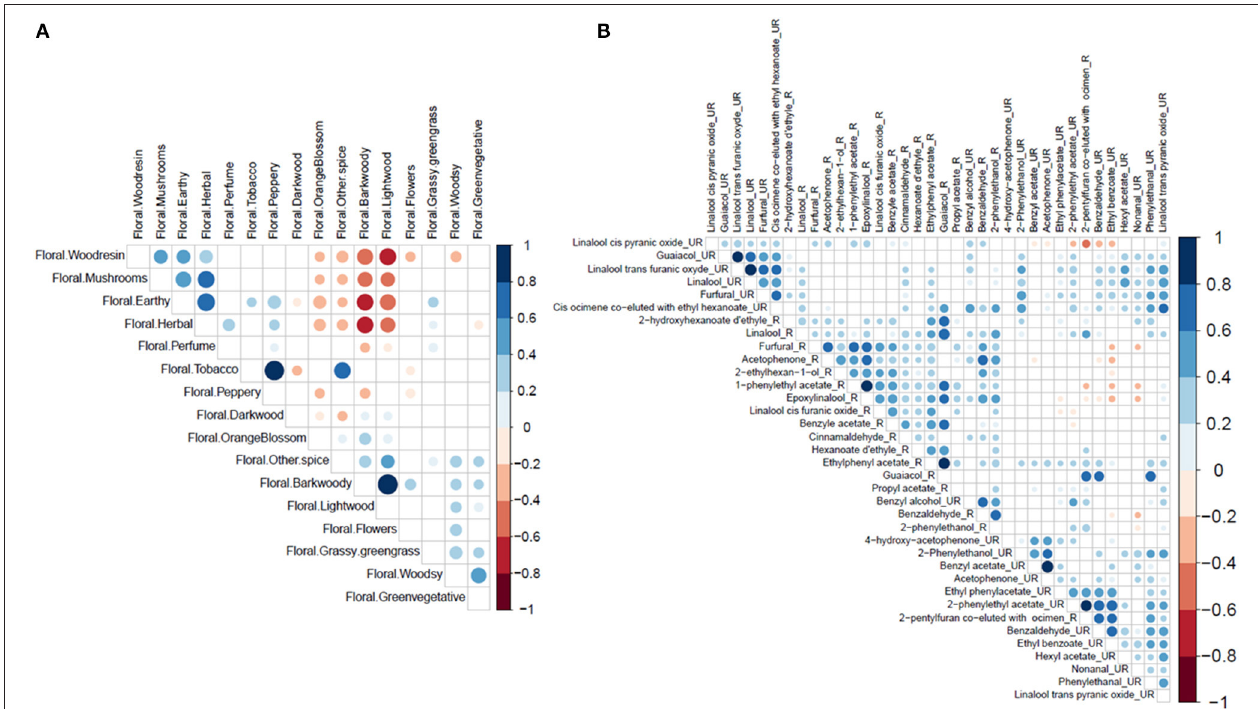
FIGURE 2 | Significant correlation matrix. (A) Correlation matrix between the sensorial profiles determined in cocoa liquor. (B) Correlation matrix between the biochemical compounds measured in unroasted (UR) and roasted beans (R). The correlations were calculated by the Pearson method. The white boxes represent no significant correlations. The colour of the circles corresponds to Pearson’s correlation coefficient. The areas of circles correspond to a p -value of correlation coefficients. The p -value threshold for a significant correlation is 0.05. The different shades of blue represent a positive correlation coefficient while the different shades of red represent a negative correlation coefficient. The intensity of the colour depends on the strength of the R2 correlation coefficient. The scale on the right indicates the interpretations of different